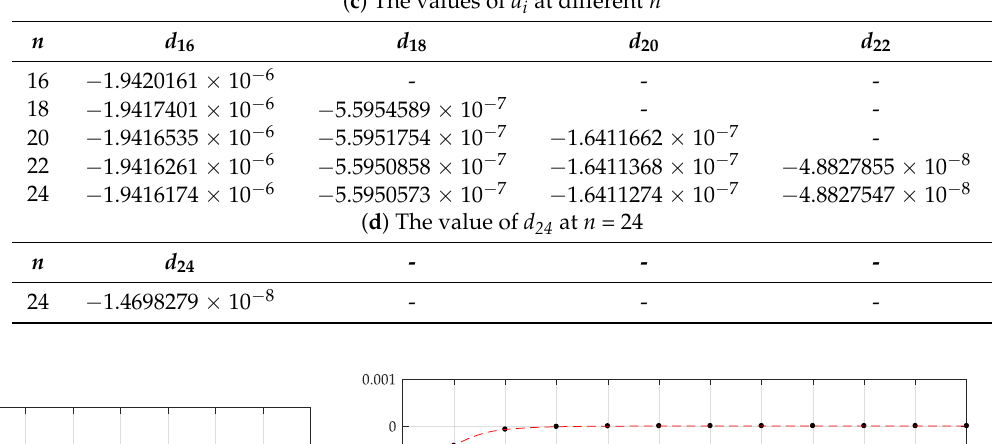
( c ) The values of d i at different n